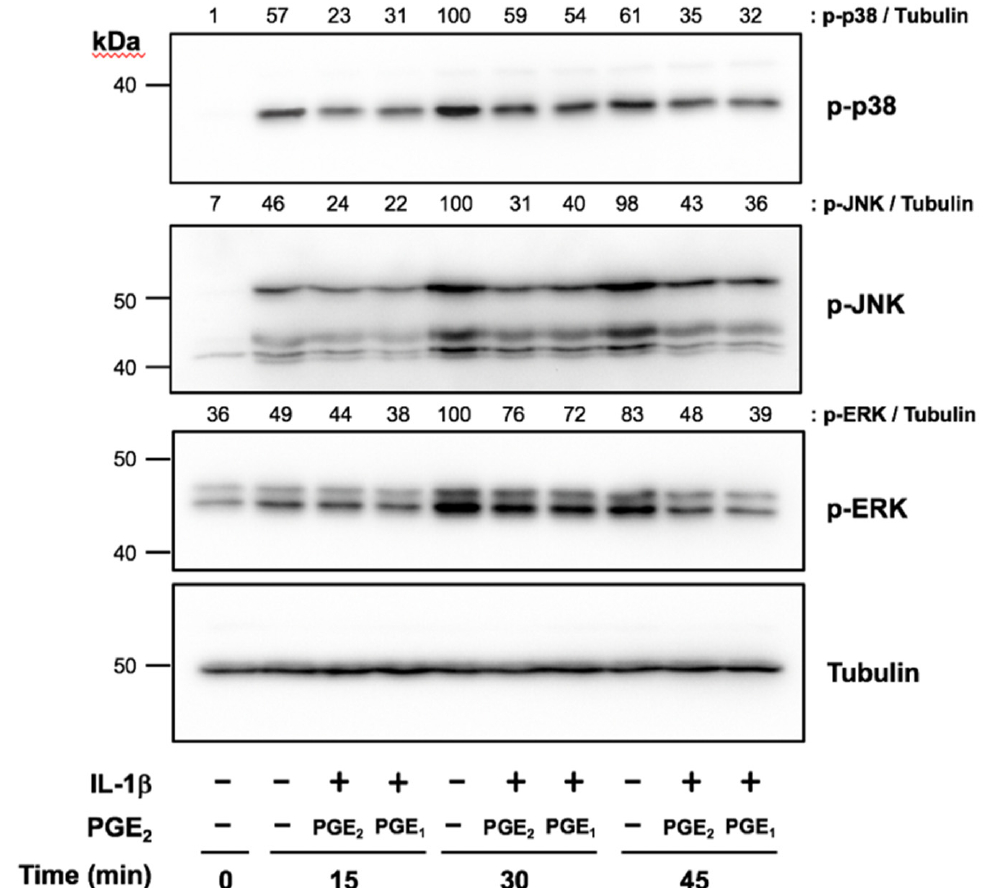
Figure 2. Effects of prostaglandin E 2 (PGE 2 ) and PGE 1 on IL-1 β -induced phosphorylation of MAPKs in human IVD cells. Confluent human IVD cells were serum starved, preincubated with PGE 2 (1 µ M) or PGE 1 (1 μ M) for 3 h, and then stimulated with IL-1 β (10 ng/mL) for 15, 30, and 45 min. The phosphorylation of MAPKs was assessed by Western blotting. Results were reproducible among four individuals, and representative blots are shown.